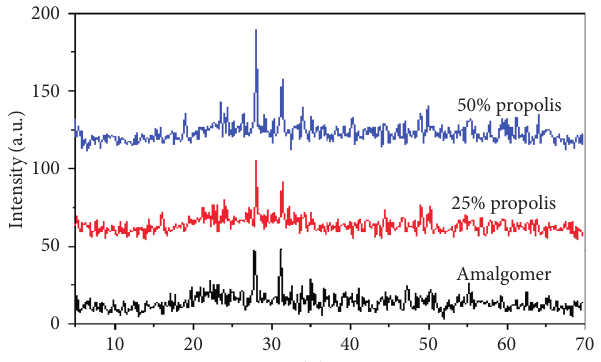
Figure 2: X-ray diffraction pattern of parent Amalgomer CR specimen and variable volume fraction composite materials containing different ratios of propolis.